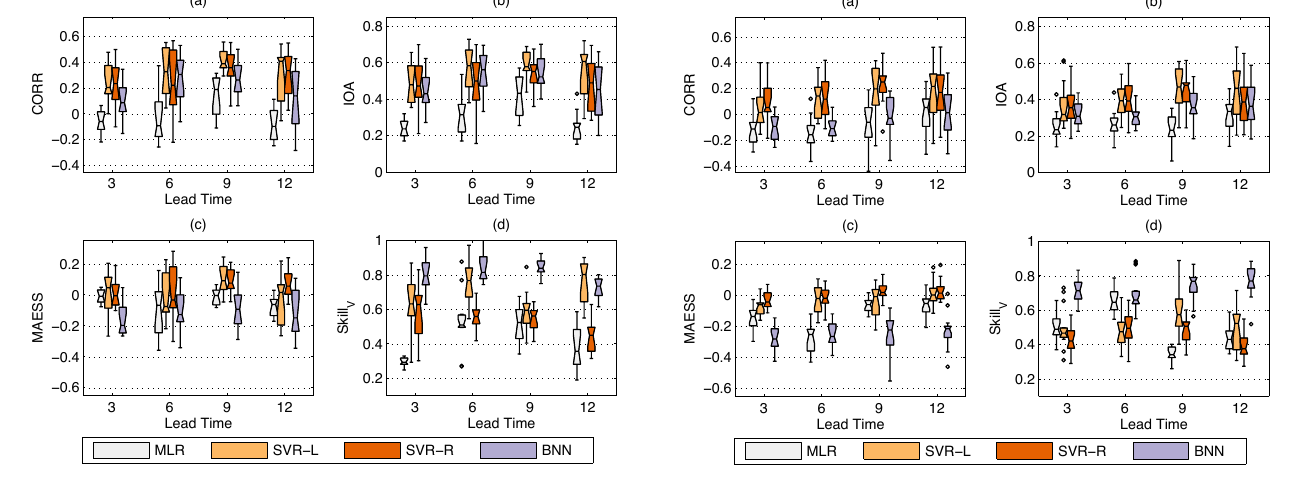
Fig. 5. Same as Fig. 2, except over the Arctic (region R4). Fig. 6. Same as Fig. 2, except over the Great Lakes (region R5).